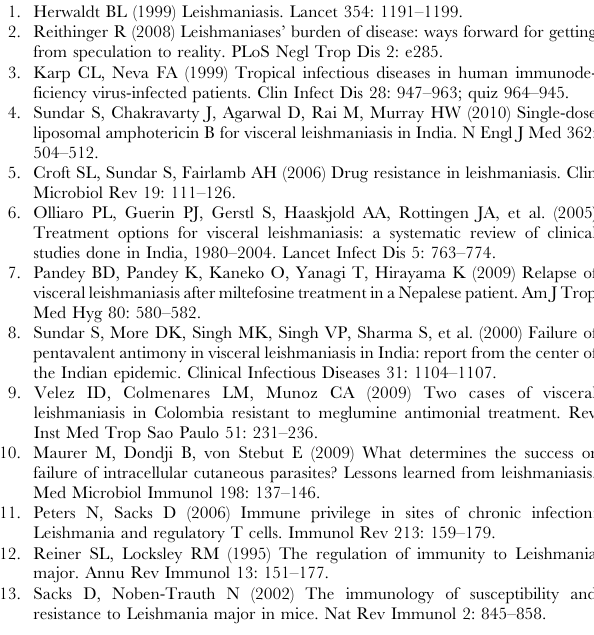
Figure S1 Gating strategy for T reg quantification. Live cells in the TCR b + CD4 + gate were analyzed for CD25 and Foxp3 expression as